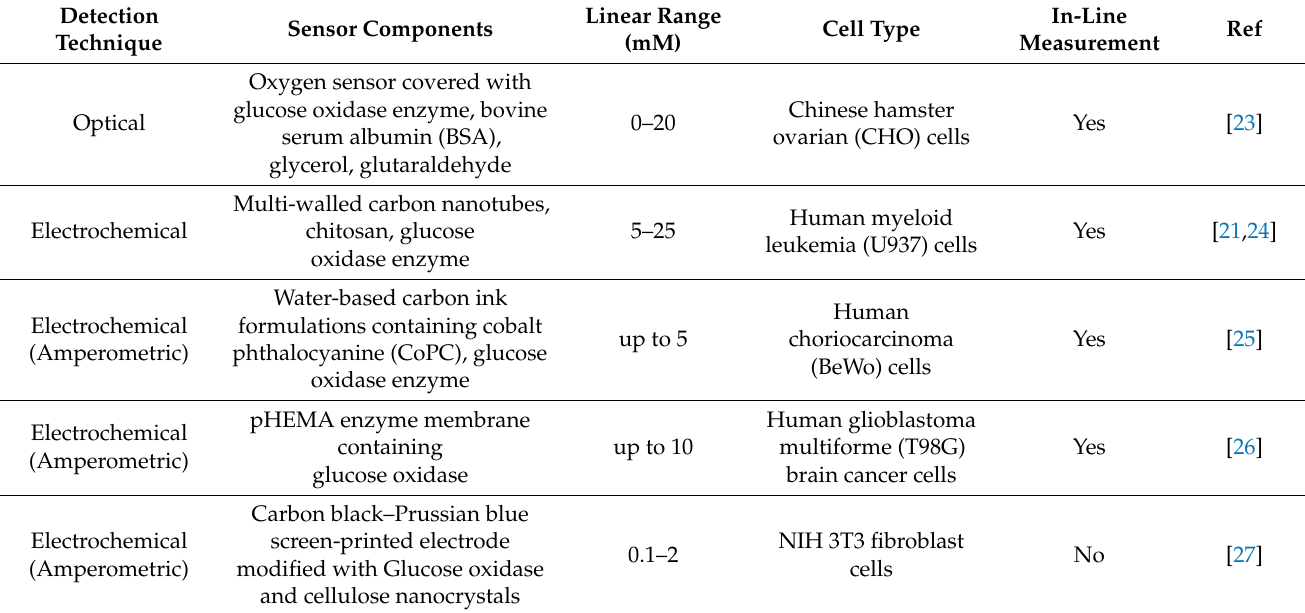
Table 1. Specification of available different enzymatic glucose sensors used in cell culture